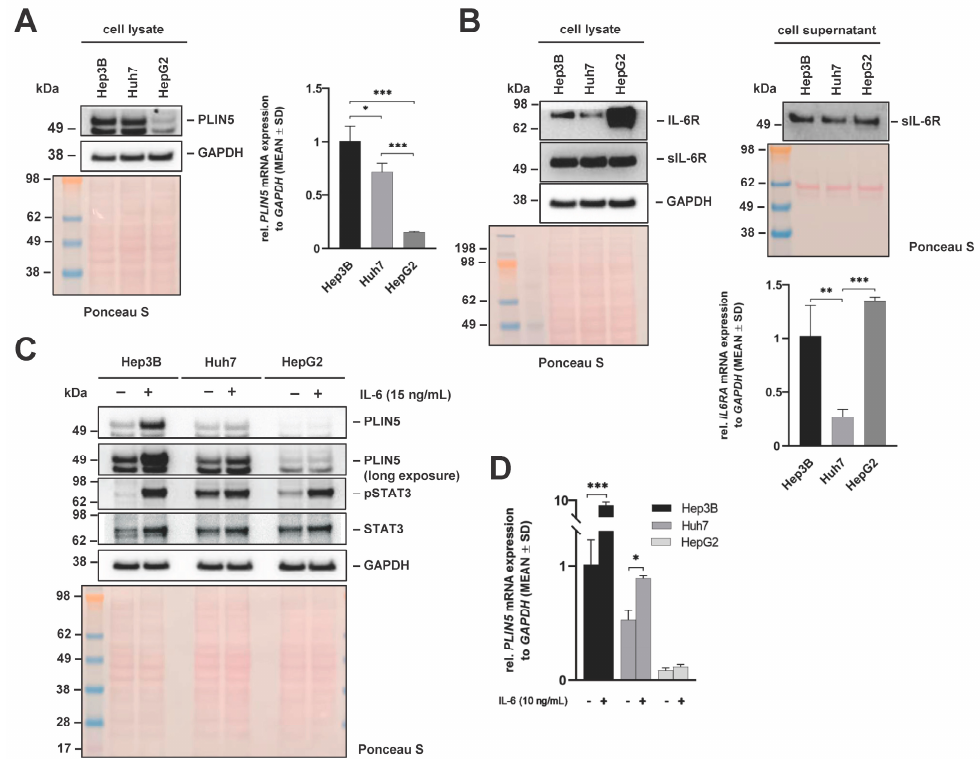
Figure 2. Basal expression of PLIN5, IL-6R, and sIL-6R after IL-6 stimulation in liver cancer cell lines. ( A ) Western blot of PLIN5 protein (left) and relative mRNA expression (right) in Hep3B, Huh7 and HepG2 cells reveal differences in PLIN5 expression between the different cell lines. ( B ) Western blot analysis of IL-6R and sIL-6R expression in cell extracts (left) and supernatants (middle) of Hep3B, Huh7 and HepG2 cells. In addition, the relative mRNA expression of IL-6RA in the three cell lines is depicted (right). Representative Western blot analysis ( C ) and RT-qPCR results ( D ) demonstrating induction of PLIN5 protein and relative mRNA expression in Hep3B, Huh, and HepG2 cells after treatment with IL-6 (10 ng/mL) for 24 h. For all Western blots, GAPDH detection and Ponceau S staining served as controls to demonstrate equal protein loading. Data for RT-qPCR results are shown as mean ± SD of three independent experiments performed in triplicate, measured in duplicate. Differences between the groups reaching significance are marked by asterisks (* p < 0.05, ** p < 0.01, *** p <